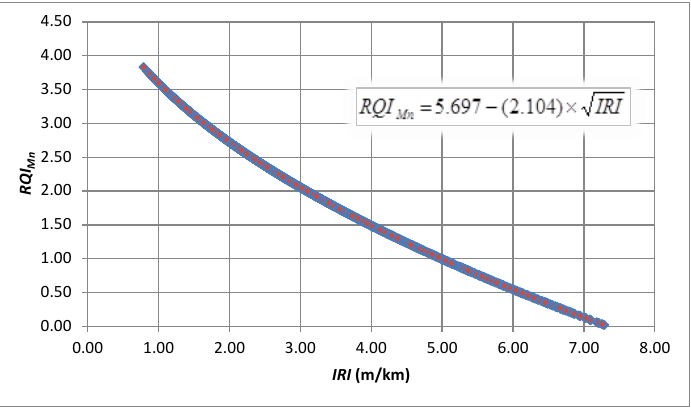
Figure 14. Correlation between RQI Mn and IRI .